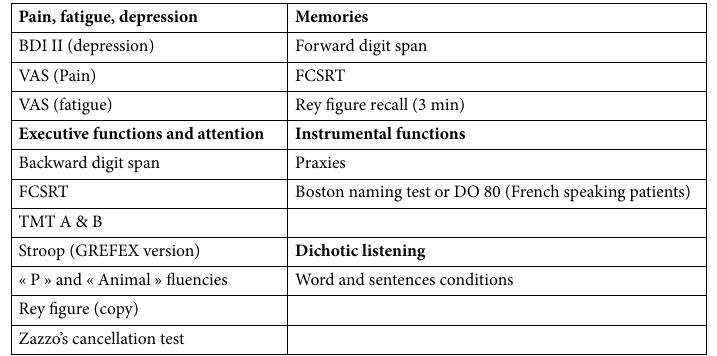
Table 11. Henri Mondor battery for the neuropsychological assessment of patients with chronic fatigue and cognitive complaints. BDI beck depression inventory, VAS visual analogic scale, FCSRT free and cued recall selective reminding test, TMT trail making test, DO Dénomination Orale (Deloche & Hannequin, 1997).